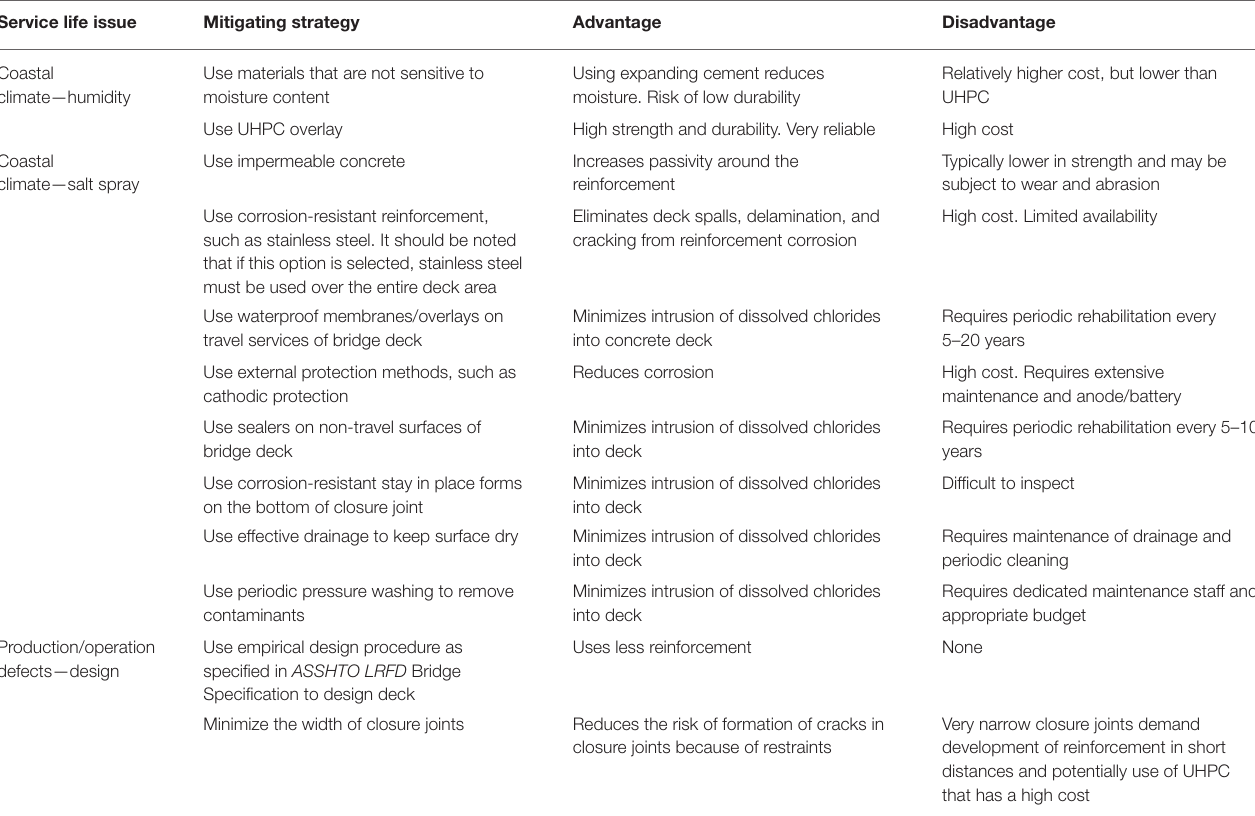
TABLE 2 | List of individual strategies for mitigating coastal climate factors and production/operation defects. Service life